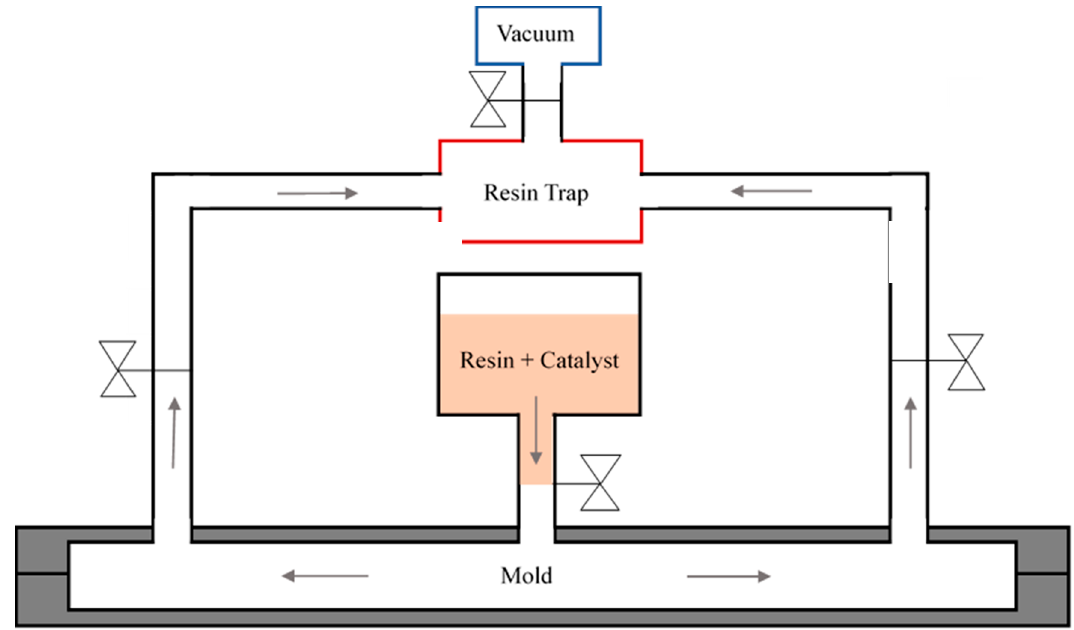
Figure 2. The schematic illustration of the experimental apparatus for the structural reaction injection molding